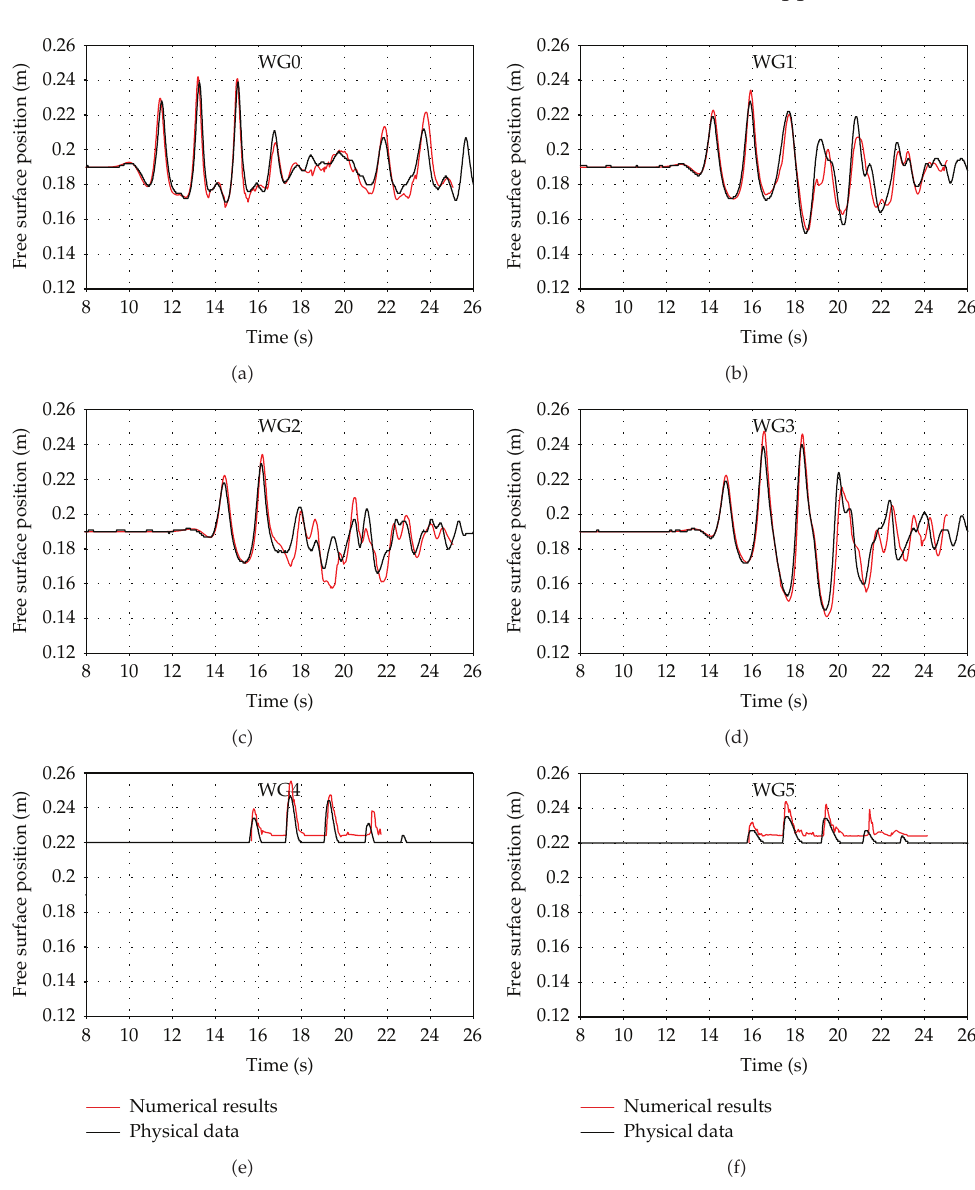
Figure 5: Numerical and physical free surface comparison at six di ff erent locations, all of them for wave case 2 defined by H (cid:9) 0 . 07m and T (cid:9) 1 .